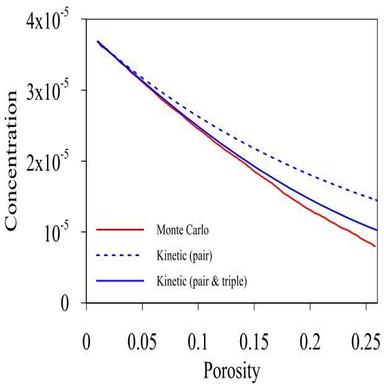
Comparison of the Monte Carlo predictions with the kinetic calculations based on the Smoluchowski equation with pair and triple collisions for a given exponential size distribution function of pores with the initial total porosity of 1%.